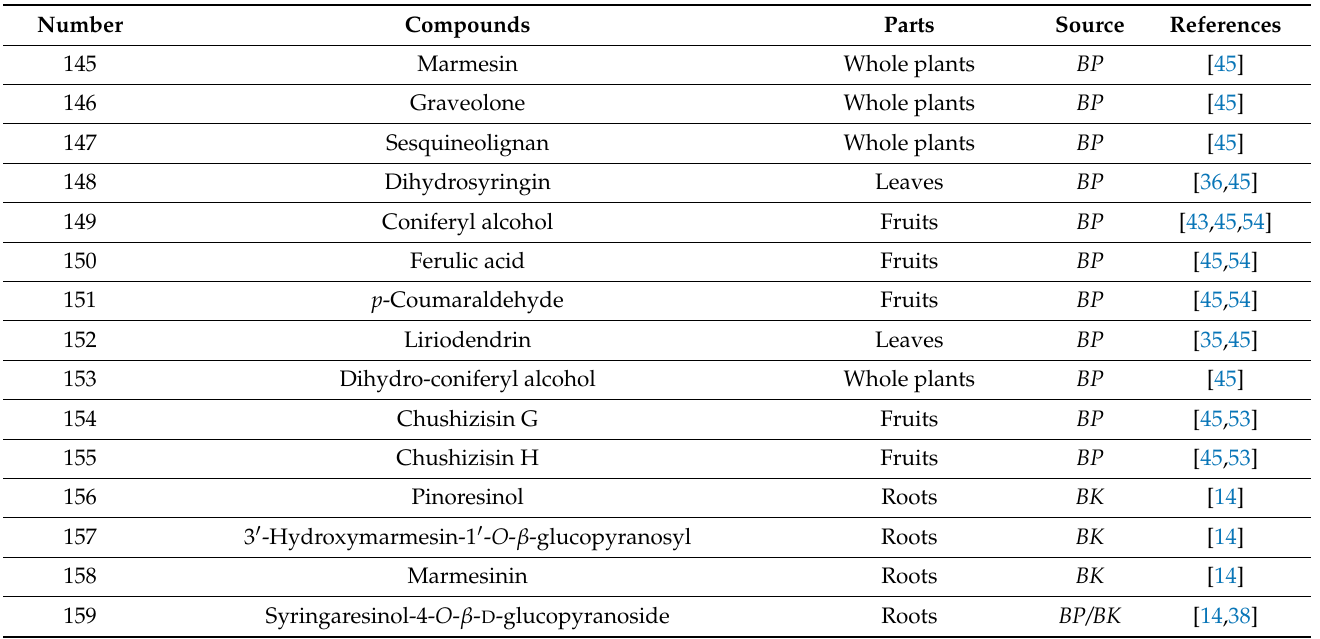
Table 2. Penylpropanoids isolated from Broussonetia